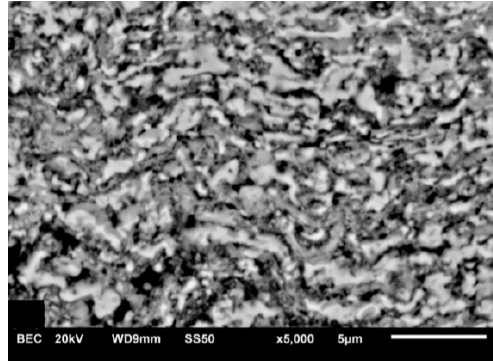
Figure 16. Cross-section of the Ni-YSZ anodes deposited via internal and axial injectors. Reproduced with permission from [31], Elsevier,